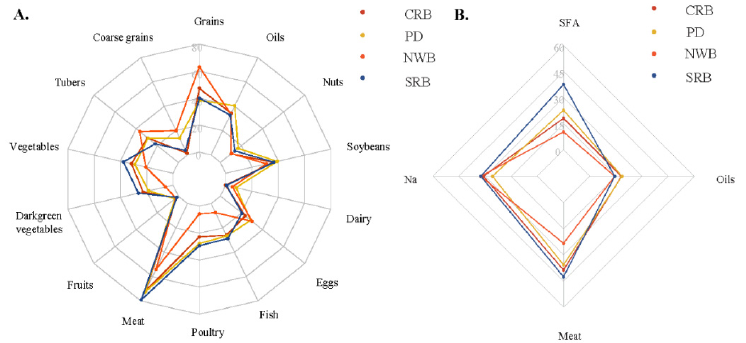
Figure 4. Proportion of subjects with different dietary patterns reaching or exceeding the recommended intake of dietary components. ( A ) Reaching the recommended intake; ( B ) Exceeding the recommended intake.